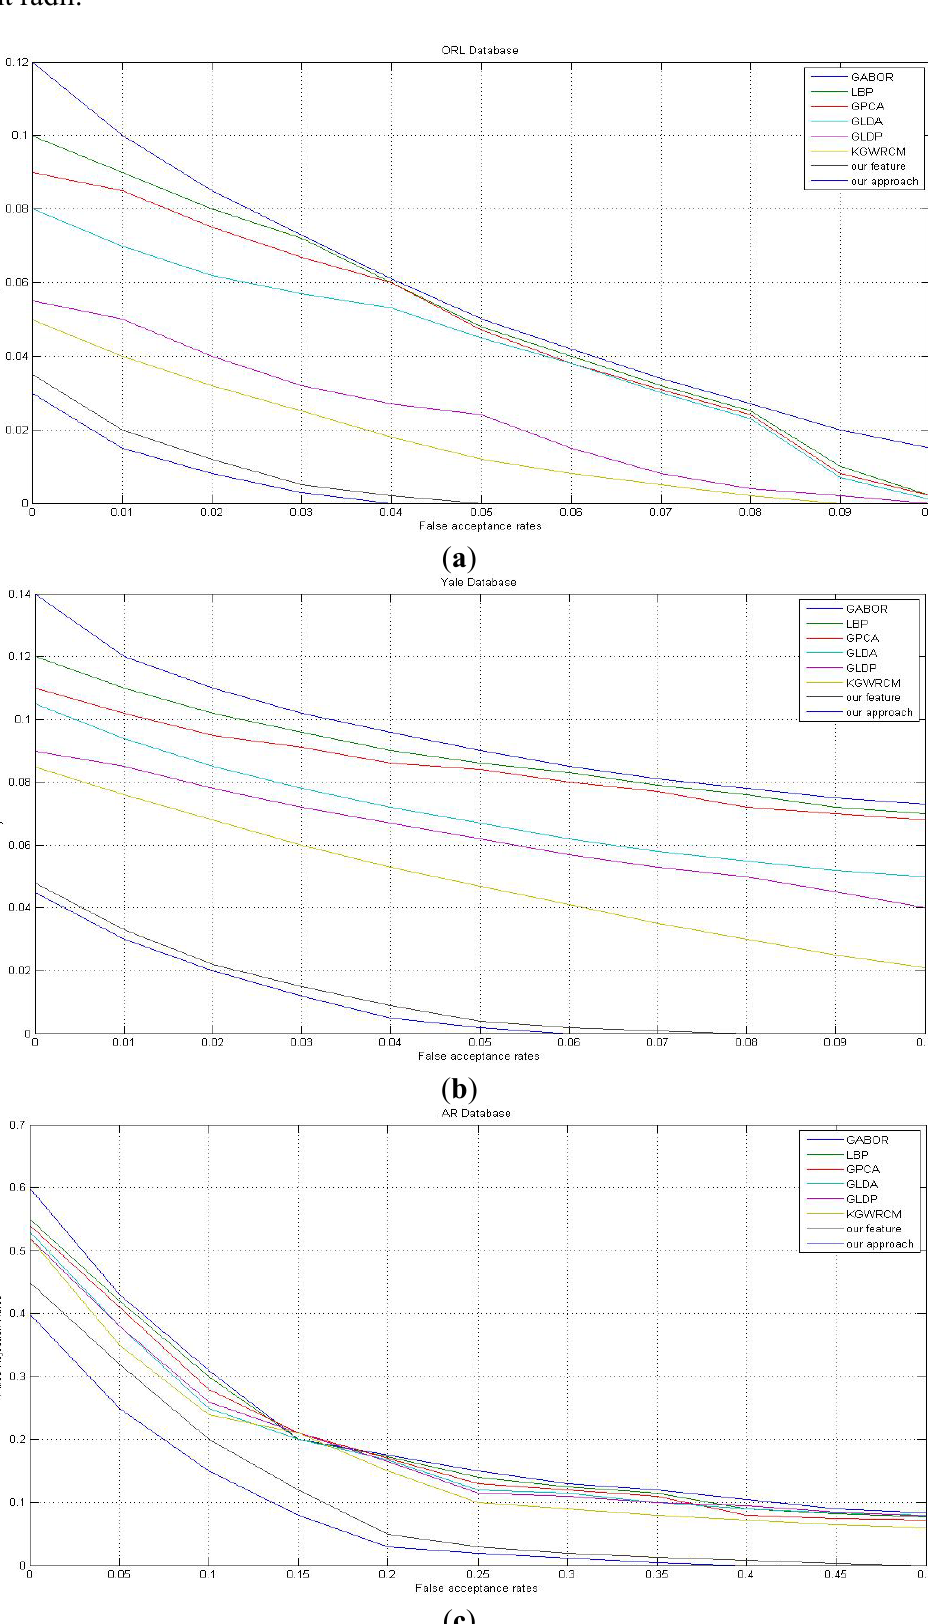
Figure 8. The ROC curve of different methods on databases. ( a – f ) in turn: ORL, YALE, AR, ABERDEEN, FRGC, FSTAR and FERET databases. ( g ) The recognition rate with different